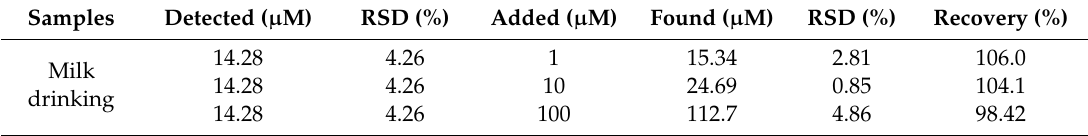
Table 2. Determination results of Allura Red in milk drinking samples. RSD: relative standard deviation. Samples